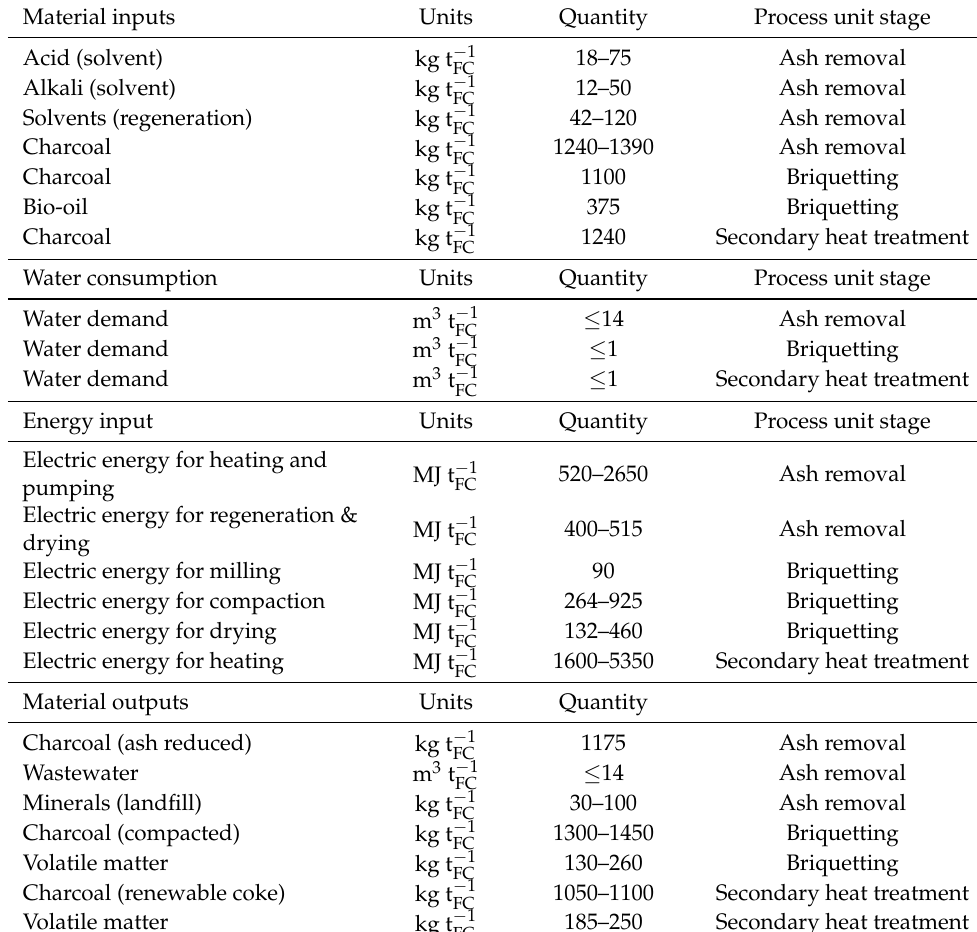
Table 8. Data summary of the unit